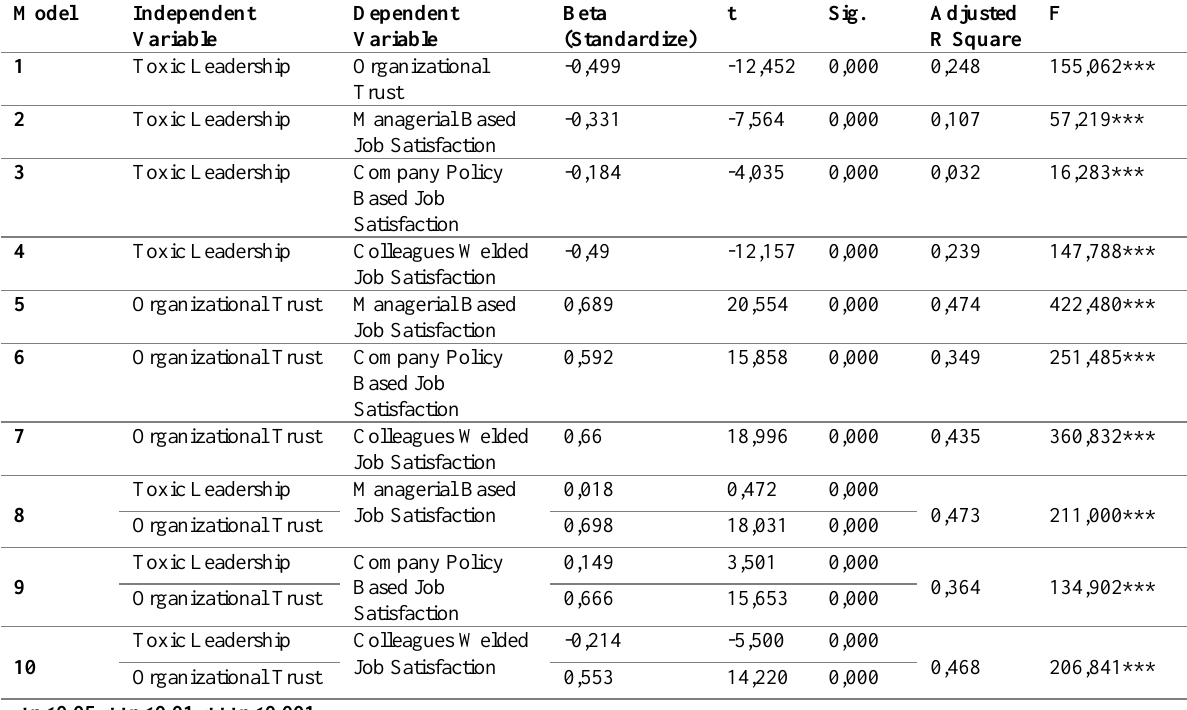
Table 5: Regression Table (Toxic Leadership, Organizational Trust & Job Satisfaction Relationship)